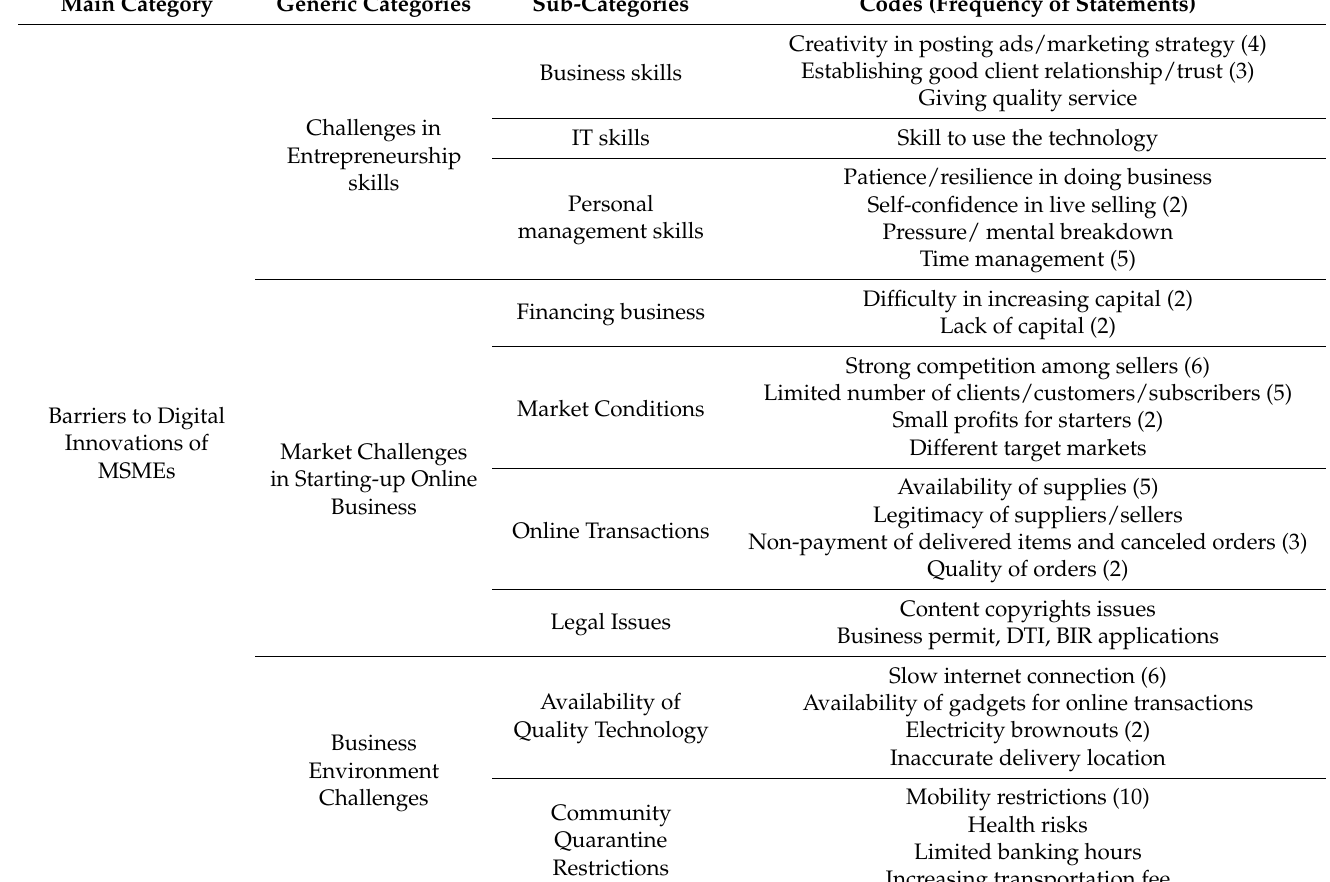
Table 2. Abstraction results of young entrepreneurs’ challenges in starting-up digital entrepreneur- ship during the pandemic (see Appendix B Table A2 for the Summary of Generated Codes and the Significant